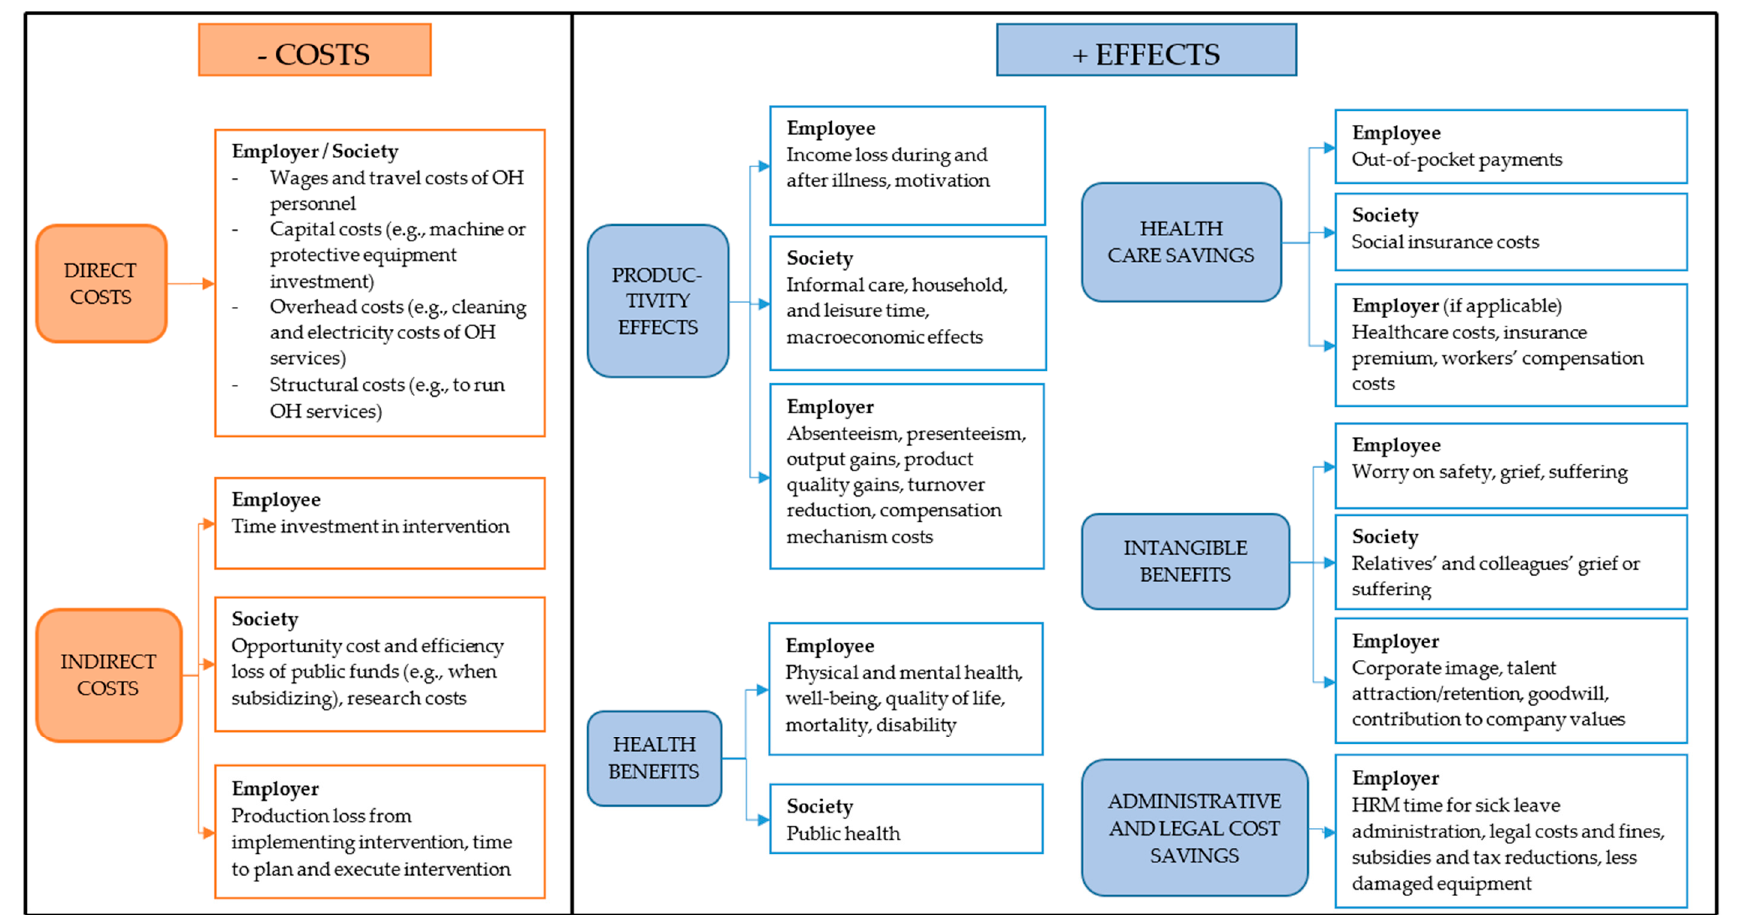
Figure 1. Costs and effects of occupational health and safety interventions, by cost and effect category and by perspective. [Blue = intervention benefits or effects; Orange = intervention costs, OH = occupational health, HRM = Human Resource Management].